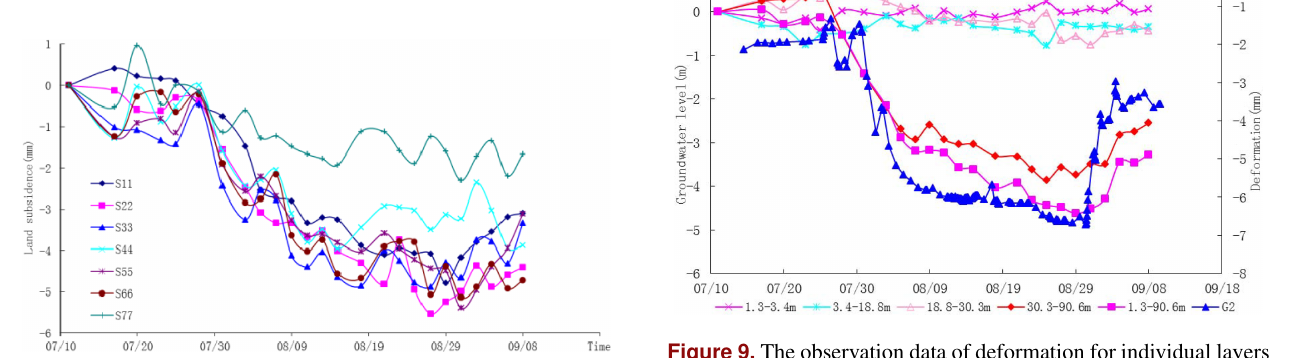
Figure 7. The observation data of land subsidence for typical mon- itoring points south of foundation pit (the distances between the monitoring points and the foundation pit are 40.5, 84.3, 100.9, 153.8, 207.8, 281.7 and 387.9m respectively).